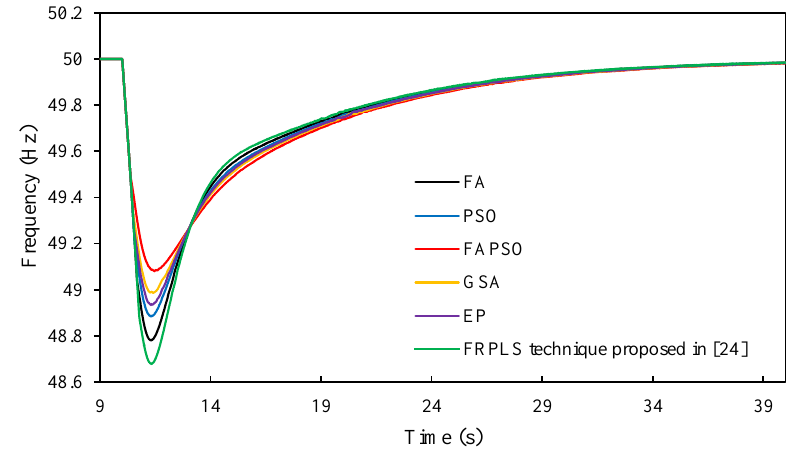
Figure 14. Frequency response of intentional islanding at 0.6 MW imbalance power. Table 9. The UFLS parameters of intentional islanding at 0.6 MW imbalance power.